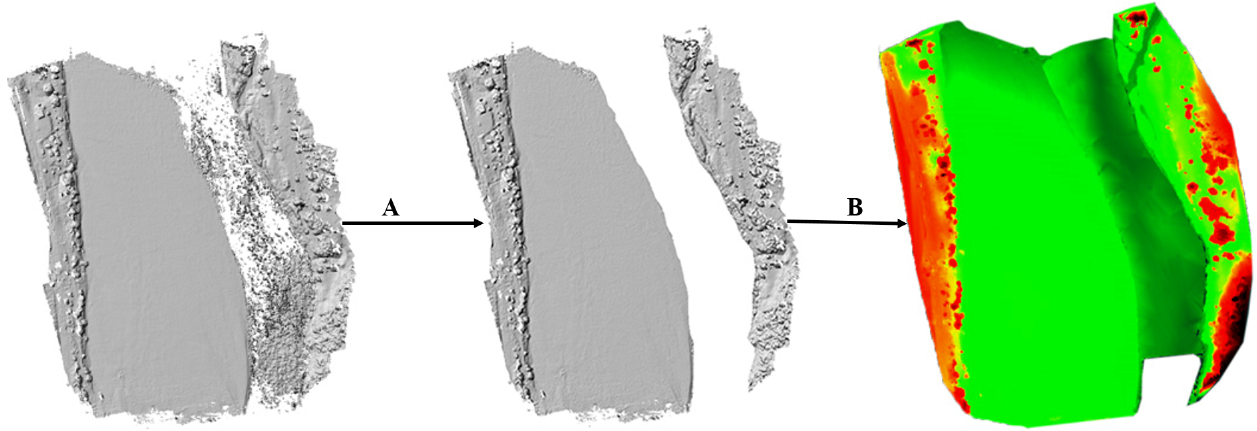
Figure 14. Floodplain processing ( a : extraction of water surface river section, b : merging dry bathymetry with wet bathymetry and volumi- sation).